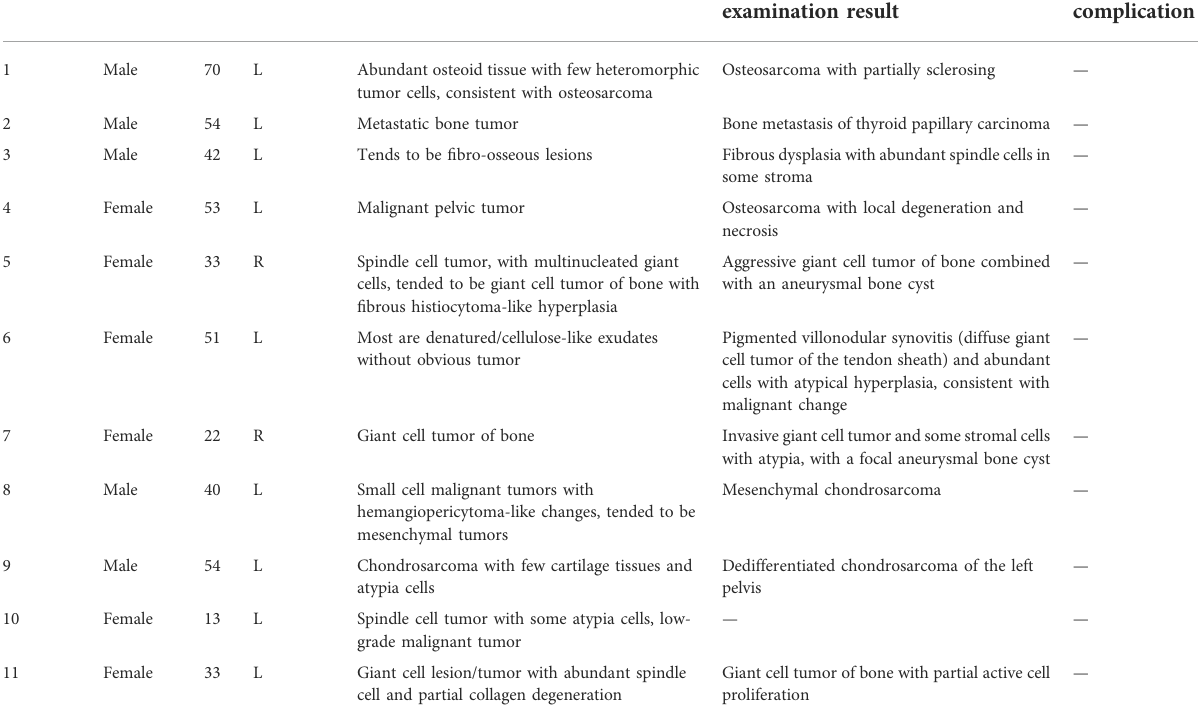
TABLE 1 Basic clinical data of patients with acetabular tumor. Number Gender Age Location Biopsy